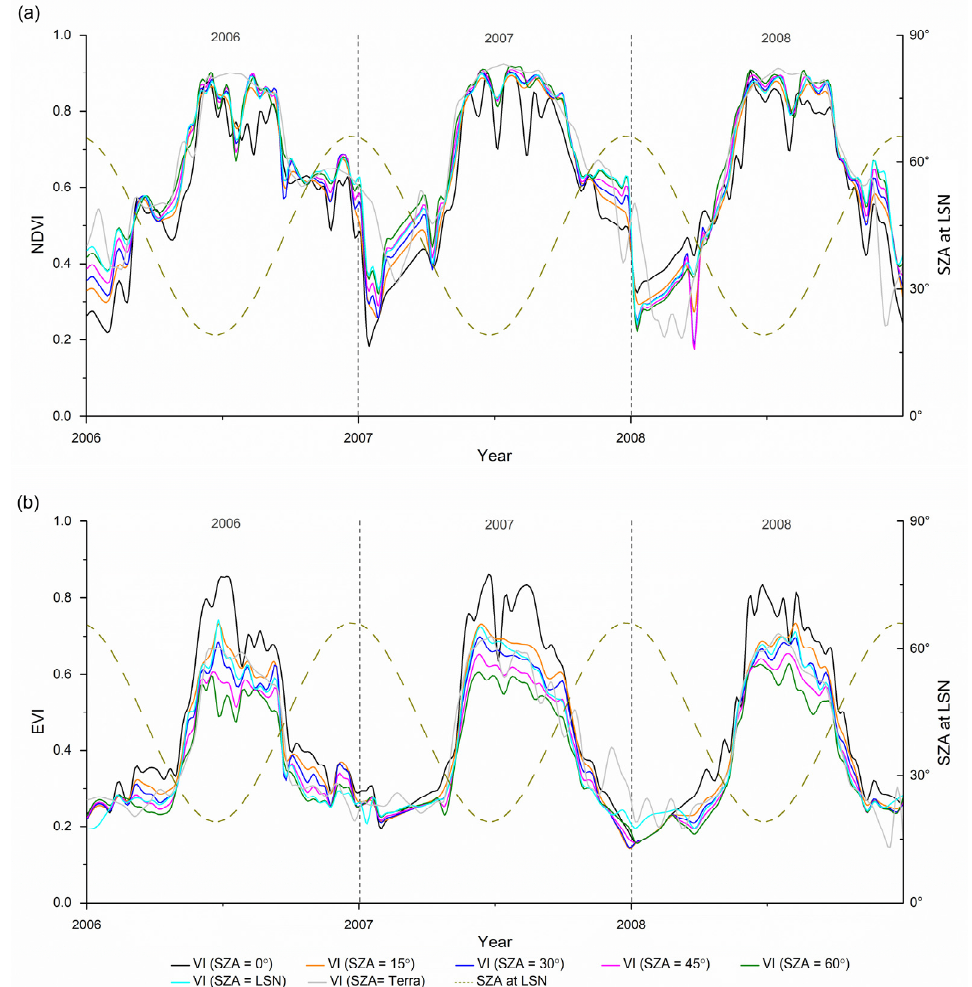
Figure 2. ( a ) NDVI and ( b ) EVI time series in the Harvard Forest from 2006 to 2008. The NDVI/EVI profiles in black, orange, blue, magenta, and green represent the NDVI/EVI that are simulated with a view zenith angle and relative azimuth angle of 0° and with a constant SZA of 0°, 15°, 30°, 45° and 60°, respectively. The cyan line denotes the NDVI/EVI time series that is generated from the MCD43A4 (NBAR) product. The gray line is taken directly from the MOD13 (MODIS vegetation index product).